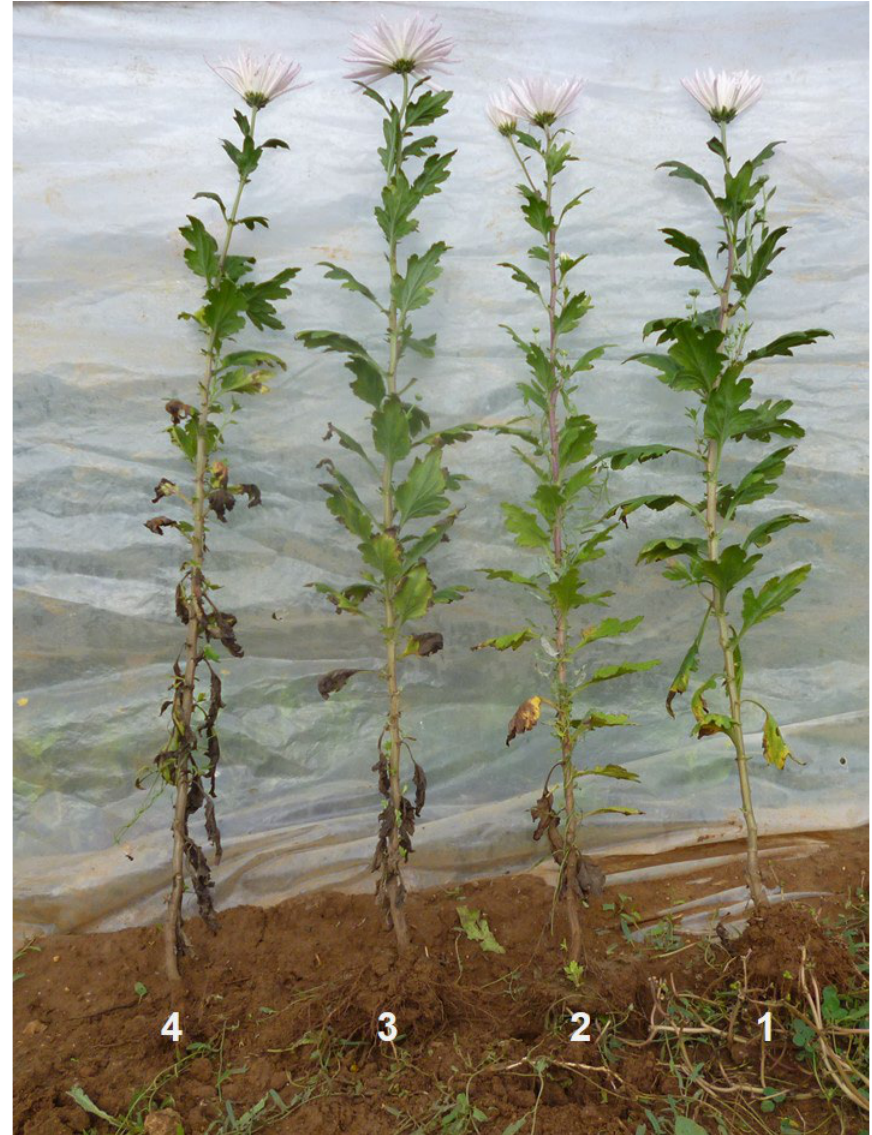
Figure 2. Disease scale consisting of 5 classes [0 = healthy stem (herein not reported), 1 = initial symptoms on basal leaves, 2 = low symptom severity, 3 = medium symptom severity, 4 = high symptom severity] used to evaluate mean severity index of Verticillium wilt of Chrysanthemum × morifolium cultivar Anastasia in field trials carried out in 2012 and 2013.